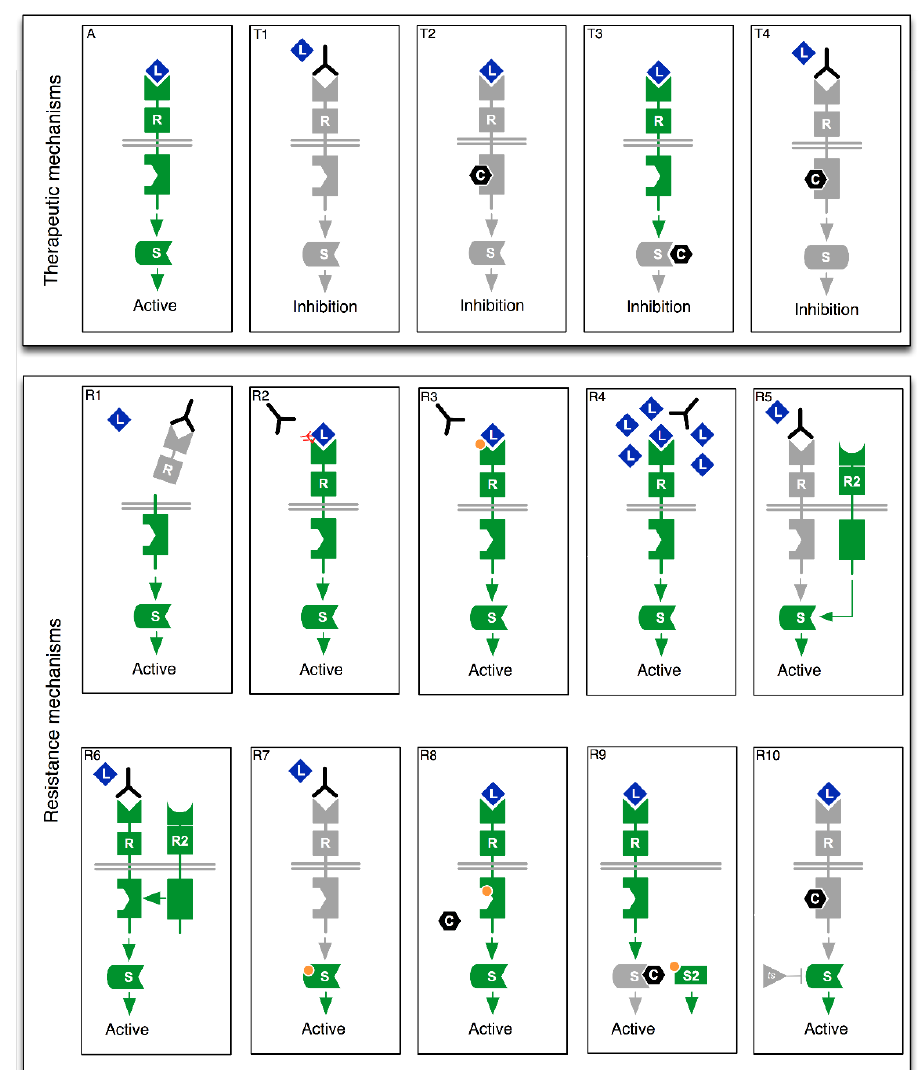
Figure 2. Schematic overview of select therapeutic strategies ( T1 – T4 ) and associated resistance mechanisms ( R1 – R10 ). ( A ). Binding of ligand (L) to receptor (R) induces active cellular signaling. ( T1 ): Antibody based therapies can block ligand induced signaling. ( T2 ): Small molecules (C) can also directly inhibit receptor kinase domain activation. ( T3 ): Downstream signaling molecules can also be inhibited by small molecule chemistries. ( T4 ): Combination approaches involving antibodies and small molecules can also be used. ( R1 ): Ecto-domain shedding of antibody epitope [9]. ( R2 ): Epitope masking [10]. ( R3 ): Mutation in Antibody binding domain. ( R4 ): Competitive inhibition of antibody binding via ligand overexpression [11]. ( R5 ): Activation of downstream protein via alternative receptor [12]. ( R6 ): Transactivation of antibody bound receptor by an alternative receptor [13,14]. ( R7 ): Activating mutation in downstream protein [15,16]. ( R8 ): Mutation in small molecule drug binding domain [17,18]. ( R9 ): Signal activation via alternative cytoplasmic signaling protein [8,19]. ( R10 ): Down-regulation of a tumor suppressor leading to activation of downstream signaling [20,21]. Green state indicates active molecule, grey state indicates inactive molecule and orange circles indicate point